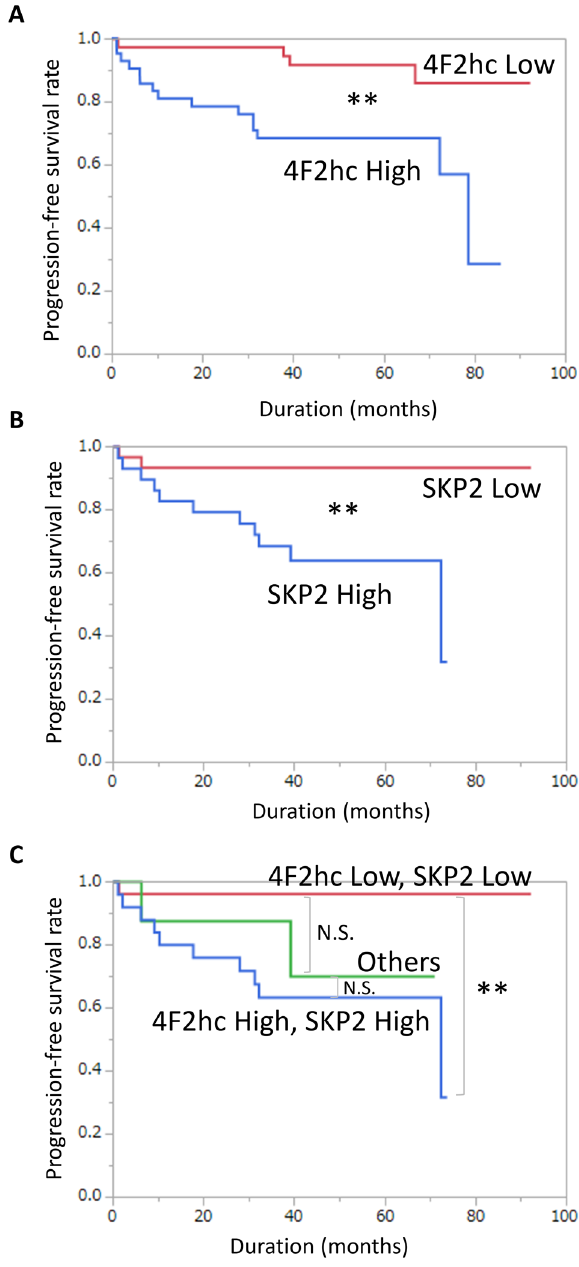
Figure 6. Progression-free survival of PC patients categorized by 4F2hc and SKP2 expression. Prognostic significance of 4F2hc expression for progression-free survival (PFS) ( A ), and prognostic significance of SKP2 expression for (PFS) ( B ). Prognostic significance of high 4F2hc/high SKP2 expression and low 4F2hc/low SKP2 expression, others are low 4F2hc/high SKP2 or high 4F2hc/low SKP2 ( C ). N.S. No significant difference. ** p <